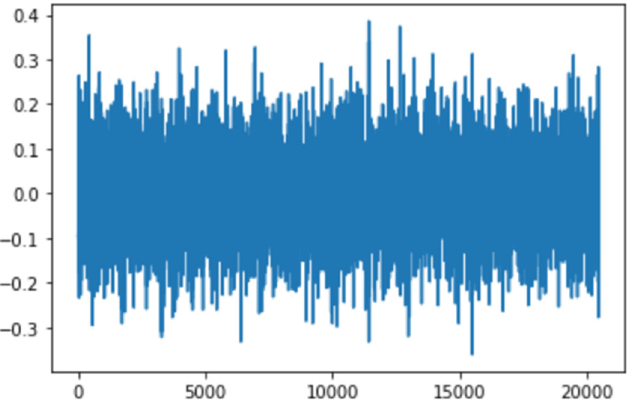
Figure 3. Vibrational signal at 10:32:39 on 12 February 2004.